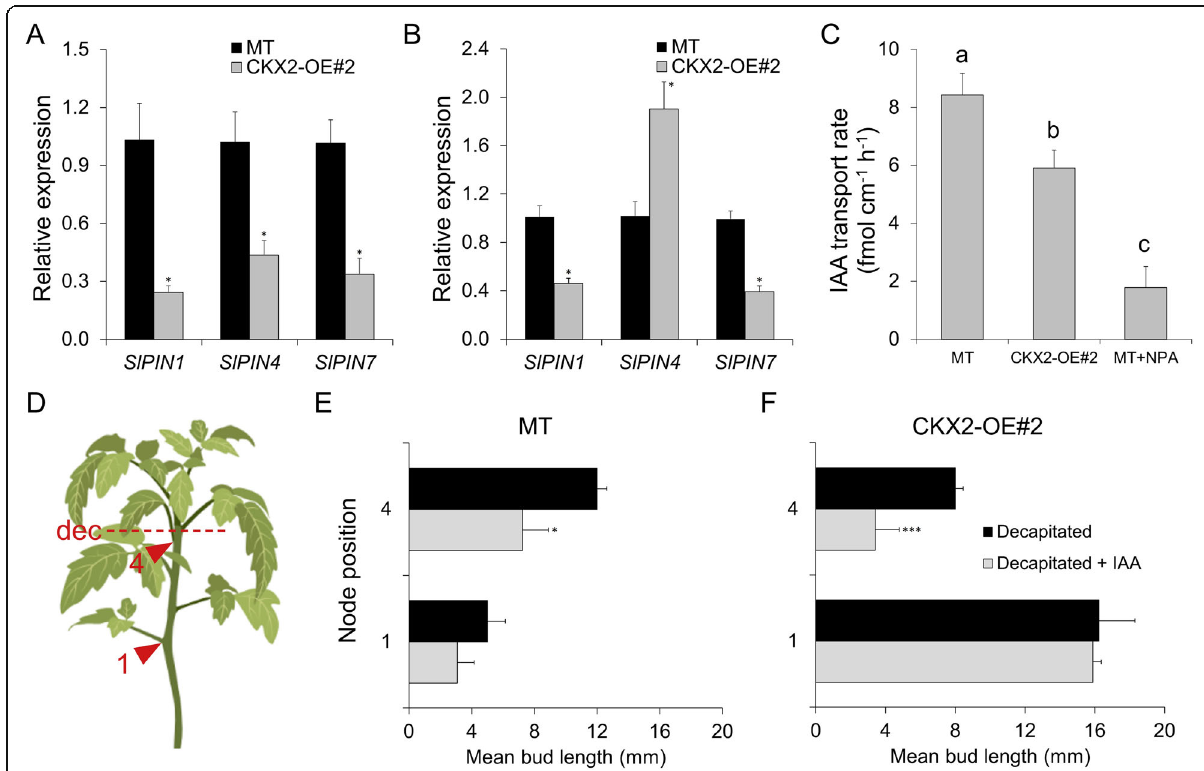
Fig. 6 Cytokinin-mediated shoot branching in CKX2 -overexpressing tomato plants is mediated by a reduced auxin transport. A and B . Expression levels of PIN auxin efflux facilitator genes ( SlPIN1, SlPIN4 and SlPIN7 ) in axillary buds (0.5 to 1.0 cm) harvested from the 3rd and 4th node of vegetative MT and CKX2-OE#2 plants ( A ) and in hypocotyl from 2-week-old seedlings ( B ). Data are means ± SE of three biological replicates. C . Reduced basipetal auxin transport in CKX2-OE#2 compared to MT plants. Auxin ([ 3 H]IAA) transport was measured in 10-mm hypocotyl sections of MT, CKX2-OE#2 and the experimental control (MT treated with 1-Naphthylphthalamic acid [NPA]). Data are means ± SE ( n = 10). D . Schematic representation of node position used in the decapitation experiment. E . Mean axillary bud length 10 days after decapitation in MT plants. F . Mean axillary bud length 10 days after decapitation in CKX2-OE#2 plants. Auxin, IAA (10 μ M) was applied to the cut stem stump immediately after decapitation. Data are means ± SE ( n = 12). Letters indicate significant differences between treatments within the same genotype and node position. A and B: Student ’ s t -test; C: Tukey test, P < 0.05; E and F: Mann Whitney test; (* P < 0.05, *** P <